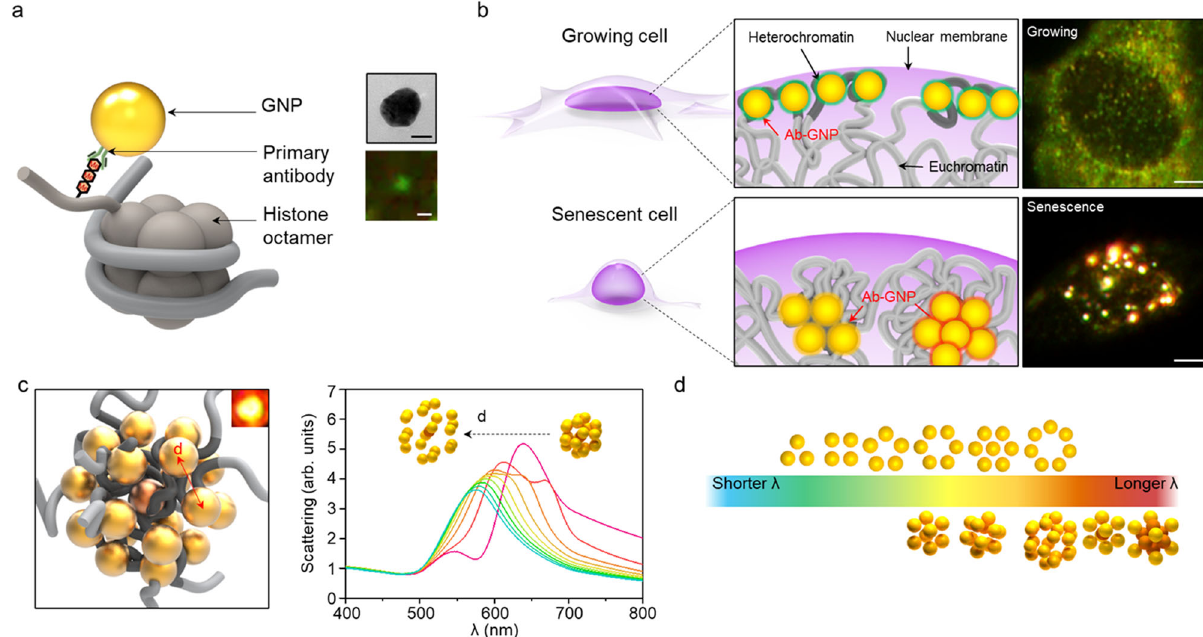
Fig. 1 Schematic illustrations of histone imaging with plasmonic nanoprobes in a single cell. a Plasmonic nanoprobe conjugated with primary antibody of histone modi fi cation marker. Electron micrograph and dark- fi eld scattering images of a single gold nanoparticle (GNP), images representative of fi ve experiments. Black scale bar, 20 nm. White scale bar, 500 nm. b Representative dark- fi eld scattering images of the plasmonic nanoprobes conjugated with antibody (Ab-GNP) targeting heterochromatin histone markers in a growing cell and a senescent cell. Images representative of fi ve experiments. Scale bar, 10 µ m. c An example of spatial arrangements of the plasmonic nanoprobes targeted to heterochromatic markers and simulated spectra of distance- dependent scattering of the probes. d Trends in the spectral peak ( λ max ) of simulated scattering according to the arrangement of plasmonic